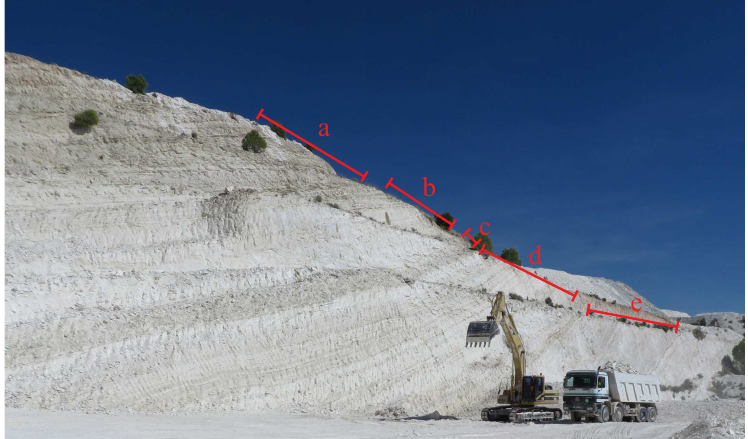
Figure 2. Active mine face section of the diatomite deposit where some of the ore samples were obtained: ( a ) limestone layer with small intercalations of diatomite; ( b ) diatomite layer with small intercalations of limestones; ( c ) limestone layer; ( d ) intercalation of diatomite, limestones, marls and clay horizons; ( e ) diatomite layer with small intercalations of